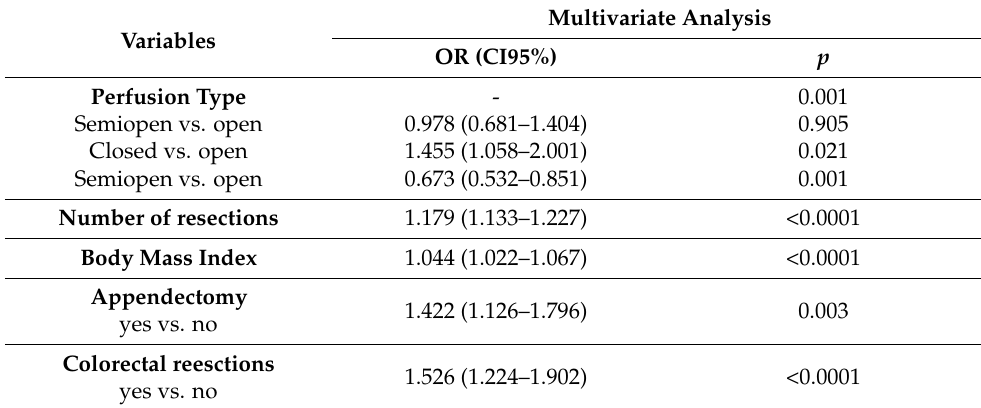
Table 6. Multivariate analysis for overall complications (total 952 cases).